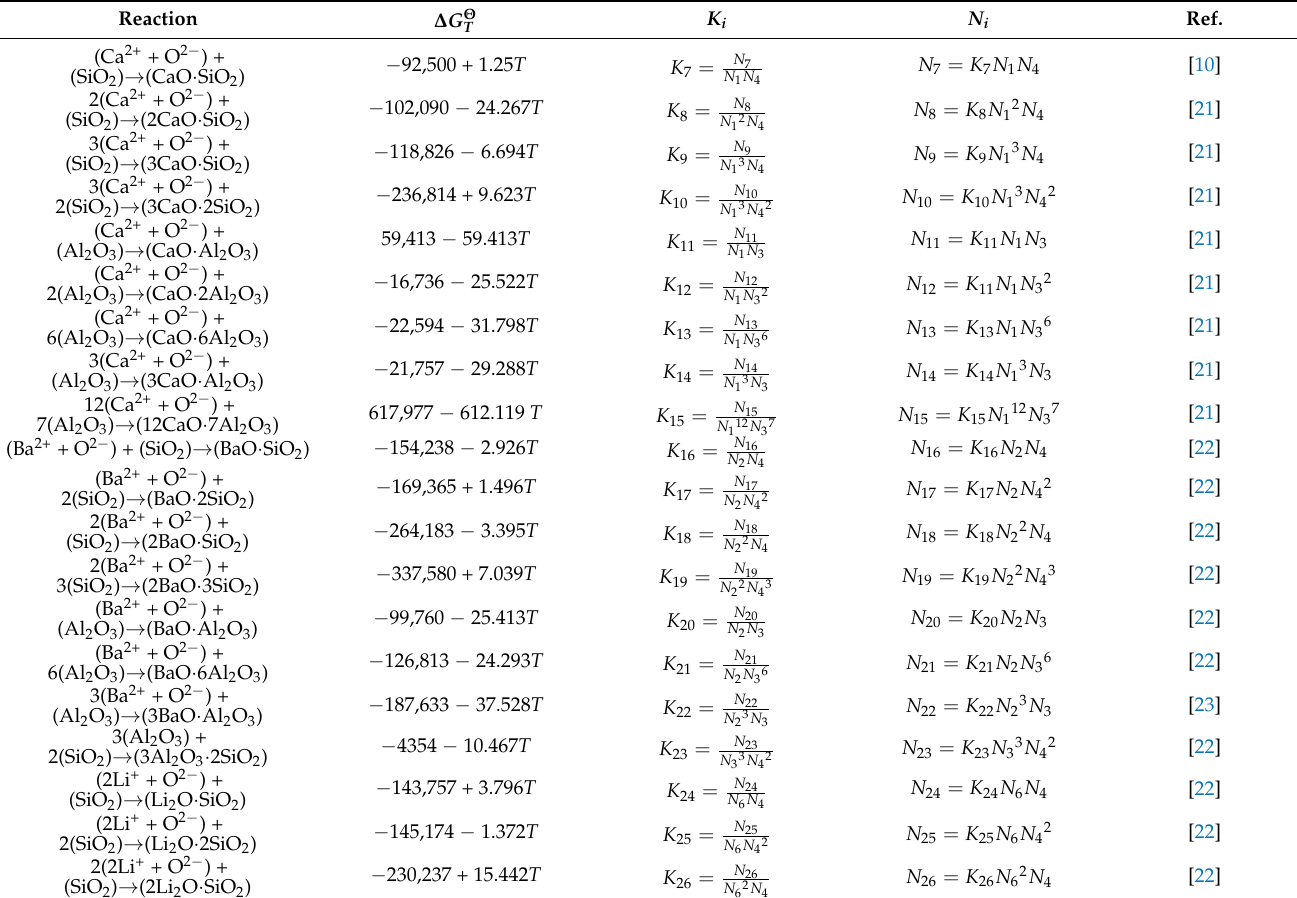
Table 2. Reaction formulas for the formation of complex